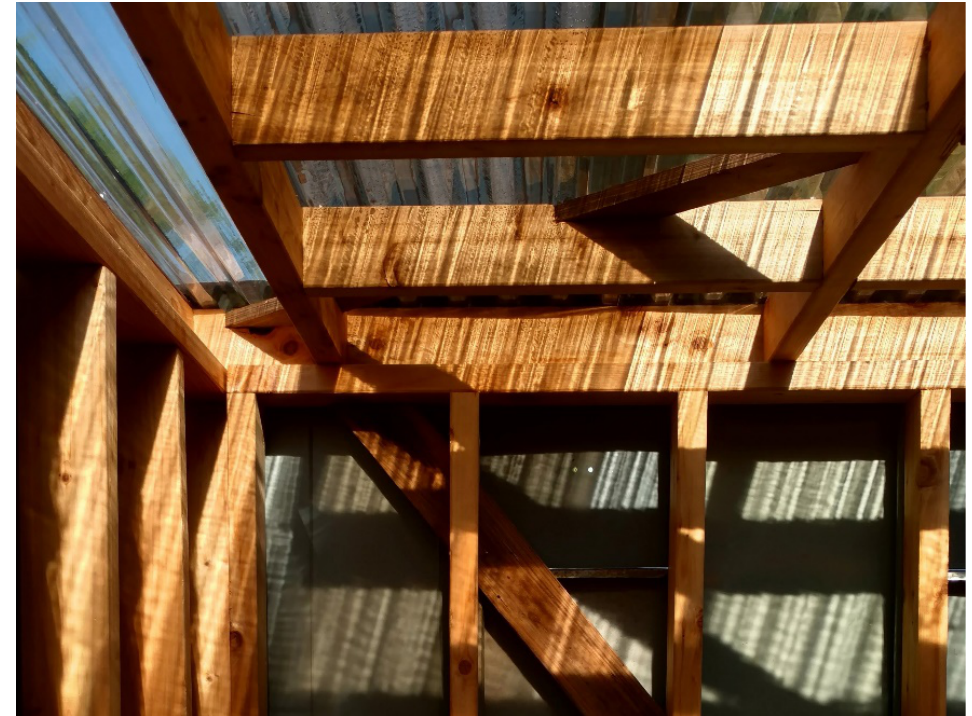
Figure 3. Wood Framing with Sun by Ana McIntosh (McIntosh and Ryzhikova 2018).